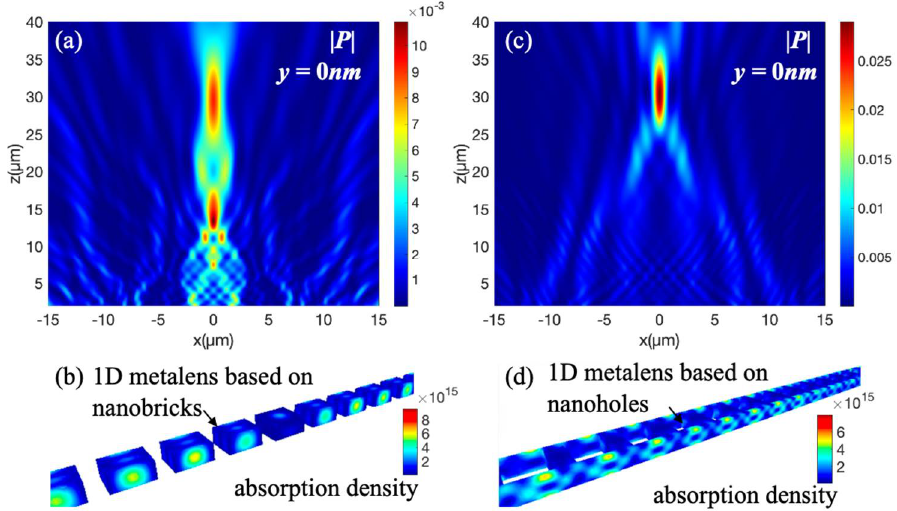
Figure 7. Focusing and absorption of the metalenses: ( a ) Intensity distribution at the focal point of the brick metalens; ( b ) The absorption density distribution in the brick metalens; ( c ) Intensity distribution at the focal point of the hole metalens; ( d ) The absorption density distribution in the hole metalens.